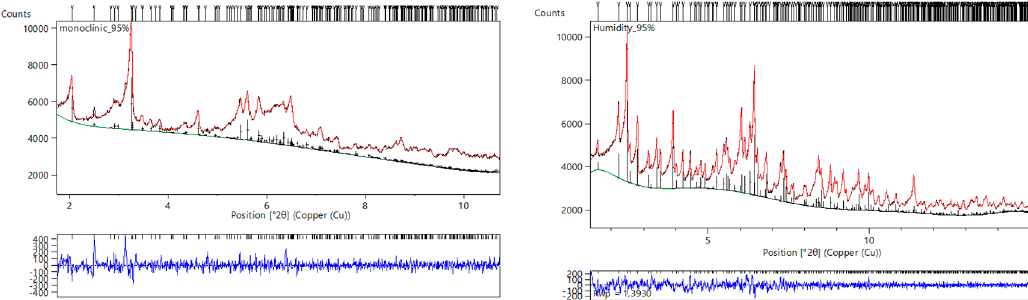
Figure 18. Pawley fits of XRPD data of monoclinic (left panel) and tetragonal (right panel) HEWL samples, loaded into a thin kapton foil holders. Data were collected using a laboratory diffractometer (Empyrean by Malvern Panalytical) ( λ = 1.540585 Å, RT). In both cases, the upper black and red lines represent the experimental data and the calculated profile, respectively, and the lower blue line represents the difference between the experimental and calculated profiles. The vertical bars correspond to the Bragg reflections compatible with the space groups P 2 1 and P 4 3 2 1 2.